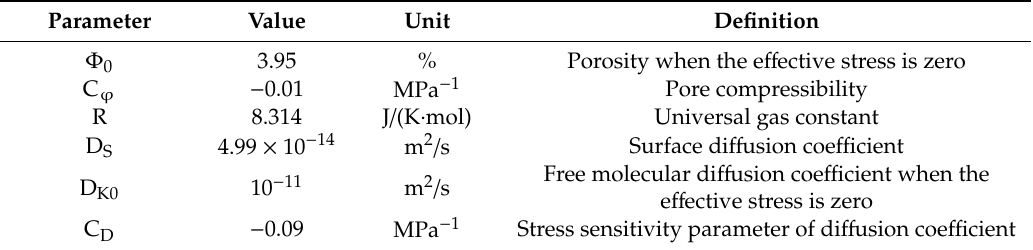
Table 2. Simulation parameters of the reservoir pressure evolution model.